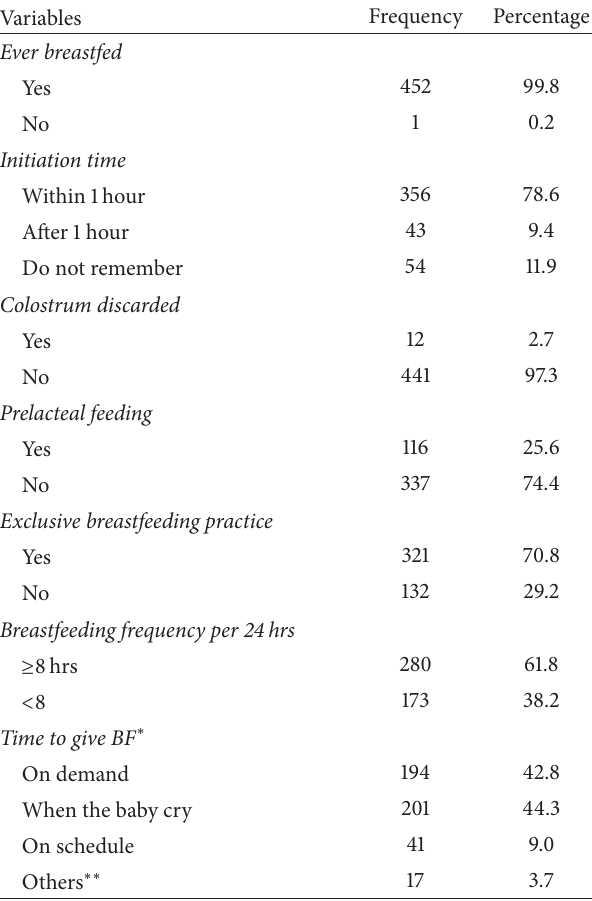
Table 2: Obstetric characteristics of participants ( 𝑛 = 453 ) in Debre Tabor town, Northwest Ethiopia, 2014.